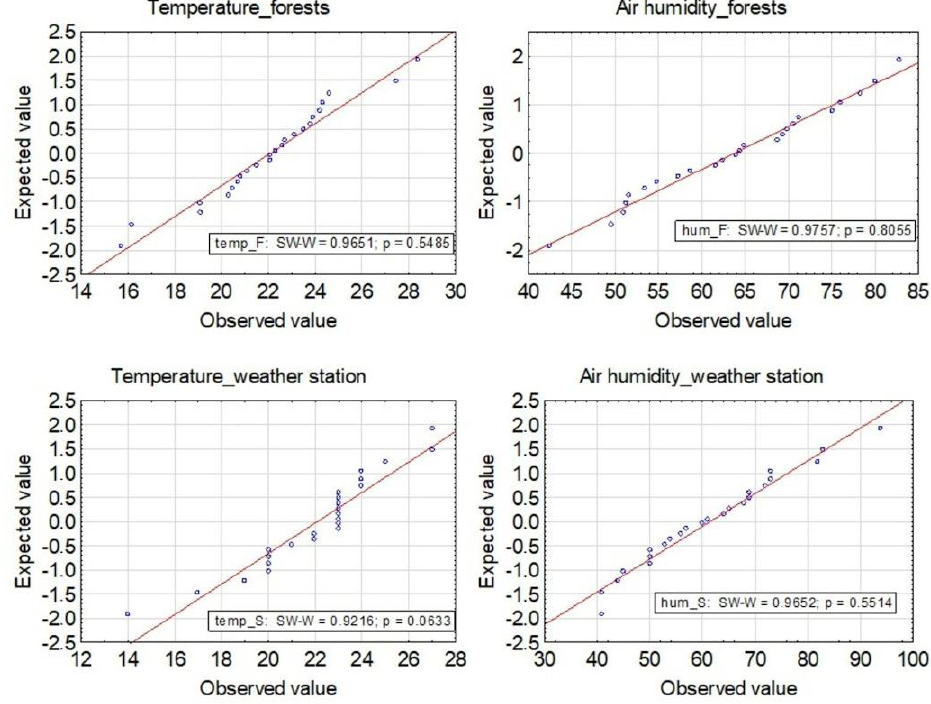
Figure 2. Temperature and humidity distribution of air examined by the Shapiro–Wilk test. Differences between mean temperatures ( t = 0.2608, df = 50.00, p = 0.7953; homo- geneous variances: F = 1.1170, p = 0.7843) and mean humidity ( t = 0.4764, df = 50.00, p = 0.6359; homogeneous variances: F = 1.3930, p = 0.4131) measured with the t -test are statistically insignificant. A negative correlation between humidity and air temperature can be observed—as temperature increases, humidity decreases (r = − 0.5065, p = 0.012). The mean ozone concentration measured in the forest sampling plots with the exception of one measurement (15 July, Hu42f, Ozone STEL = 19 µ g-m − 3 ) was always below the LOQ. In contrast, the mean ozone concentration measured in the Rzesz ó w city park on both measurement days was 19 µ g-m − 3 , with a maximum instantaneous concentration of 622 µ g-m − 3 (Table 2). A study by Peters et al. [54] showed that ozone concentrations recorded during air sampling resulted in a 10–50% decrease in terpene